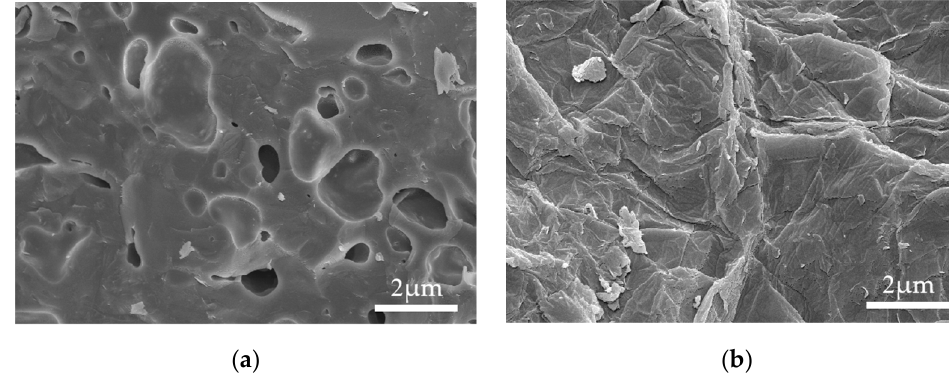
Figure 2. SEM images: ( a ) SC; ( b ) GO.